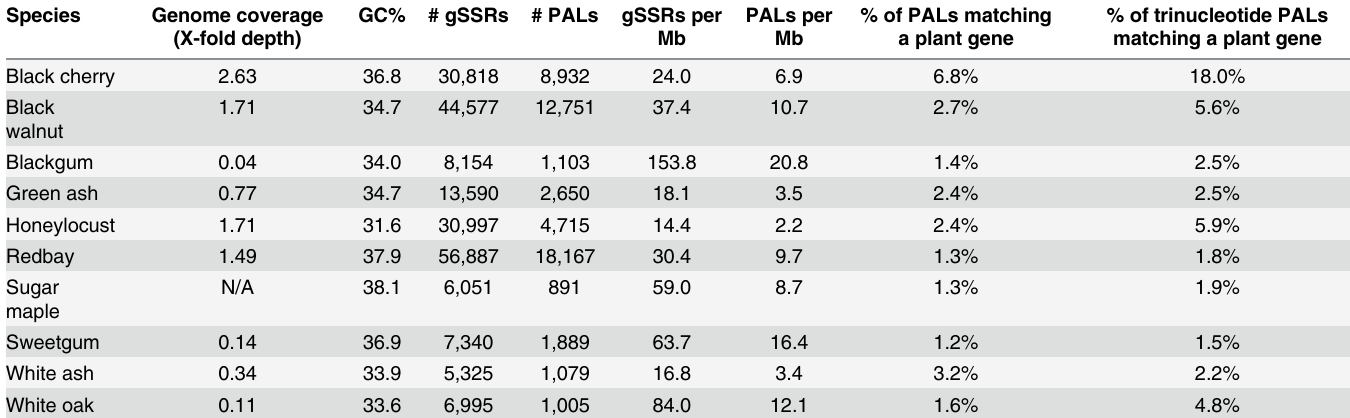
Table 3. Statistics from low coverage whole genome sequencing and microsatellite discovery. Species Genome coverage (X-fold